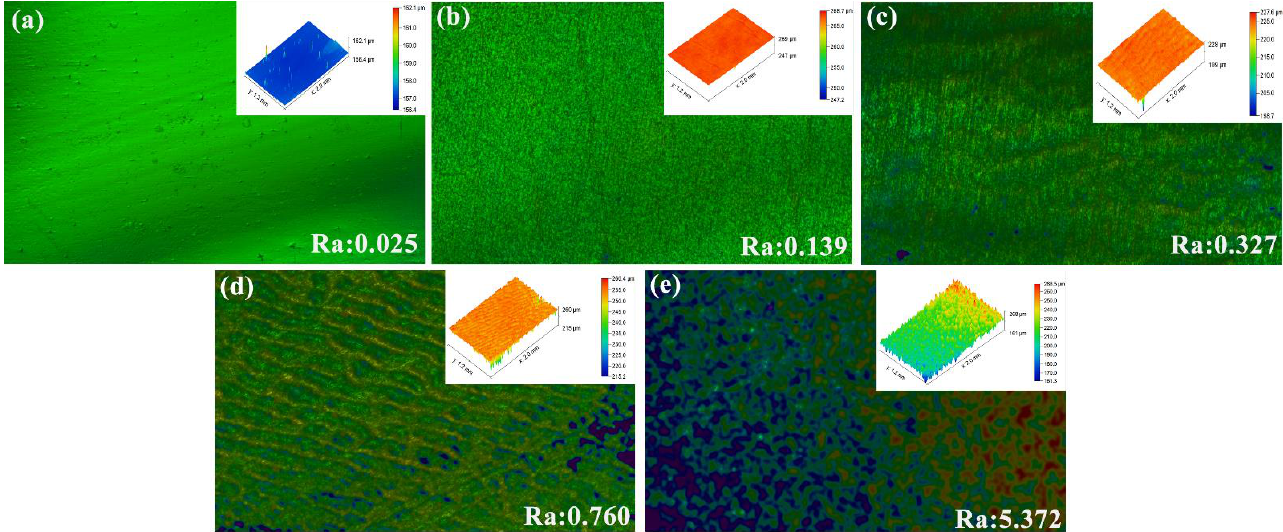
Figure 6. Surface optical images and surface roughness of different samples ( a ) As-fabricated; ( b ) 10 μm; ( c ) 5 μm; ( d ) 3 μm; ( e ) 1 μm.